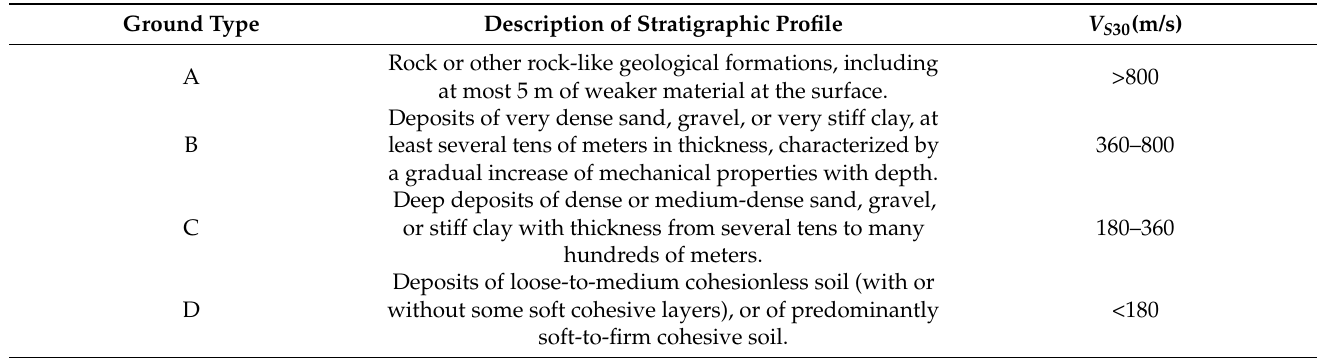
Table 1. Ground-type classification based on